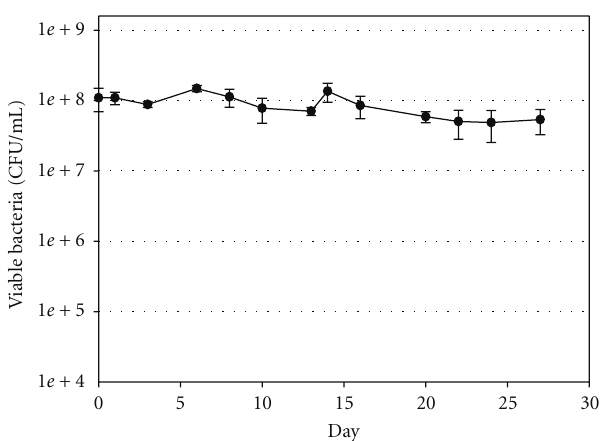
Figure 2: Survival of E . coli O157:H7 in sterile stream water microcosms at 15 ◦ C at 60rpm. The average concentrations of E . coli O157:H7 were determined by the spread plate method and are shown as CFU per milliliter. Error bars represent standard deviations about the means ( n = 4).